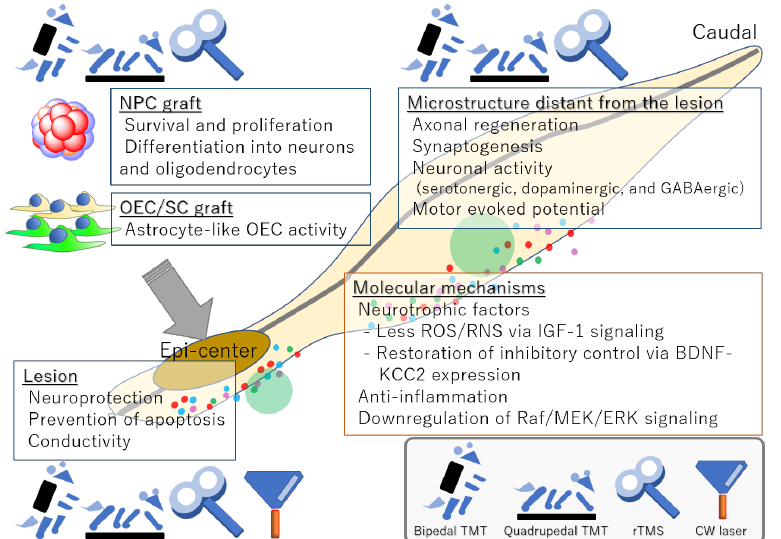
Figure 1. A schematic summary of the combinational effects of rehabilitation and regenerative treat- ment. BDNF: brain-derived neurotrophic factor; CW: continuous wave; IGF-1: insulin-like growth factor 1; KCC2: kalium-chloride cotransporter 2; OEC/SC: olfactory ensheathing cell/Schwann cell; ROS/RNS: reactive oxygen species/reactive nitrogen species; rTMS: repetitive transcranial magnetic stimulation; TMT: treadmill training.